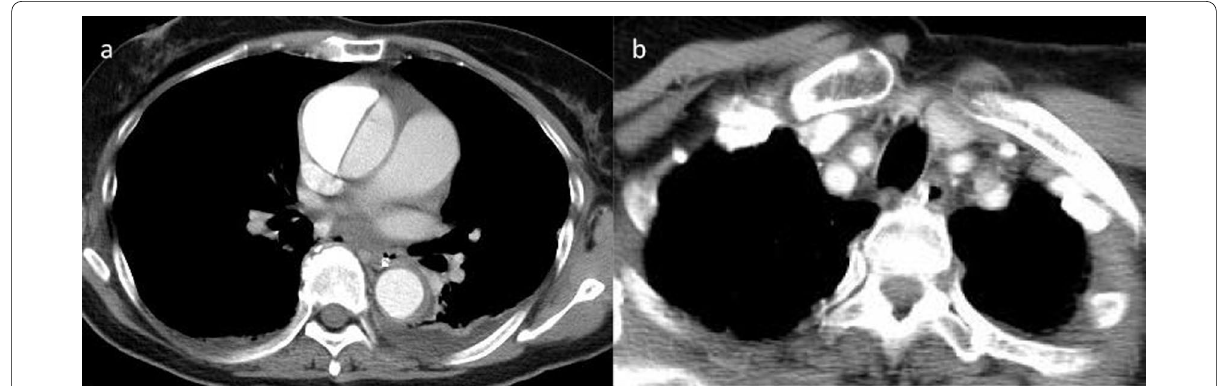
Fig. 2 Chest CT shows double-barrel aortic dissection on the day of onset ( a ) and the dissected right common carotid artery with the false lumen thrombosed ( b